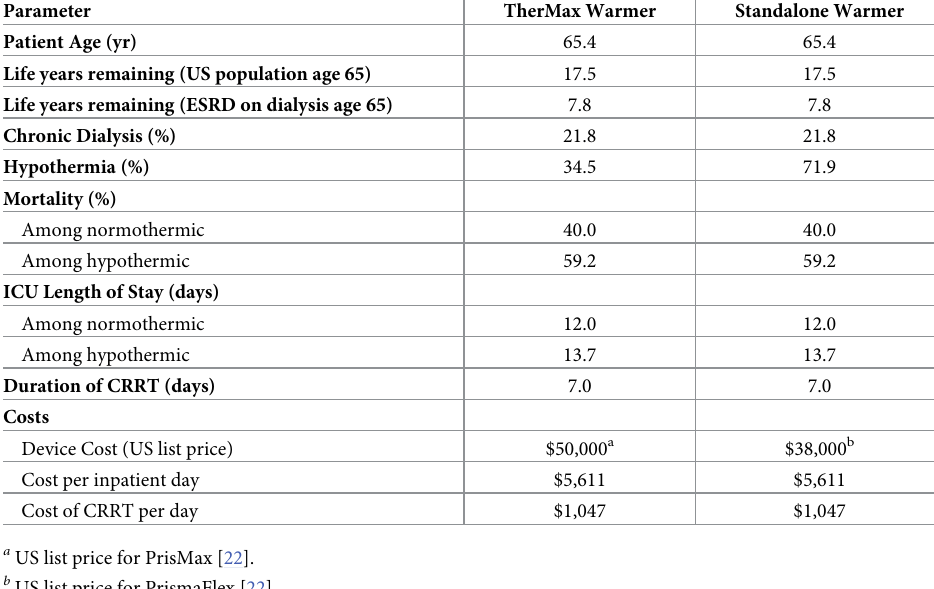
Table 2. Primary model